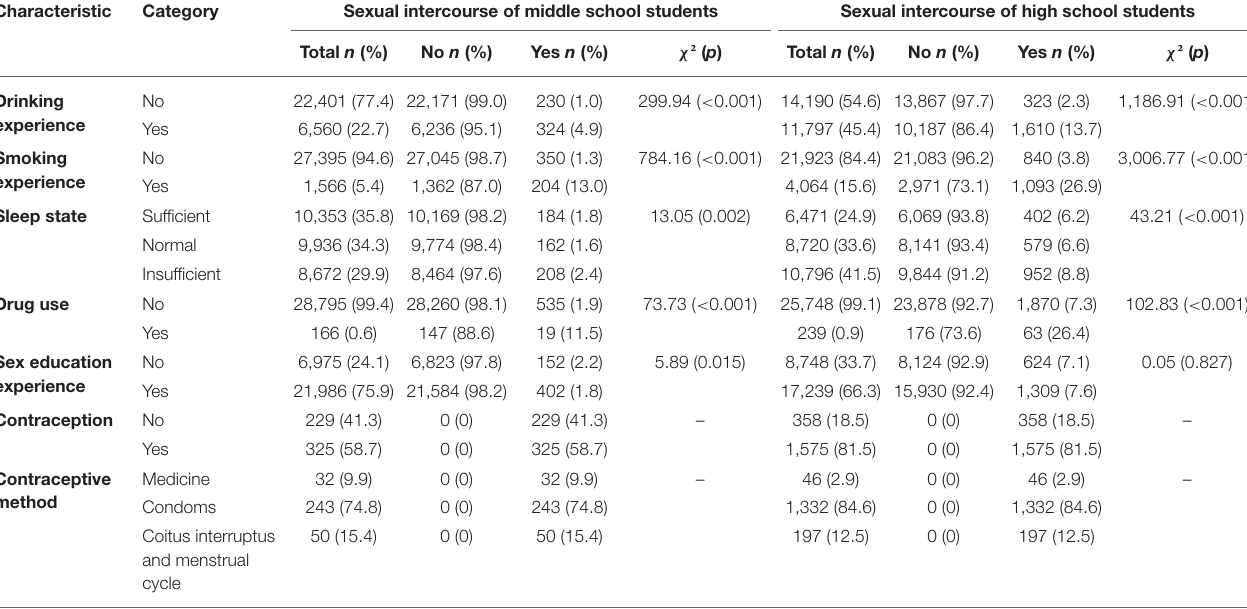
TABLE 2 | Health behavior characteristics of the participants ( n = 54,948).